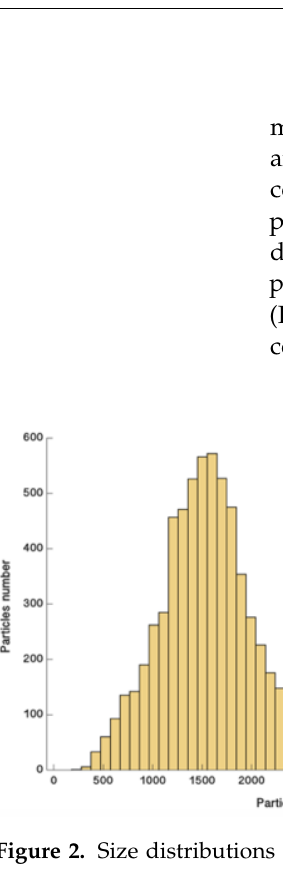
Figure 1. Morphologies of Titan’s tholins obtained with a FEG SEM for the images ( a ) – ( d ), and an environment SEM for the images ( e ), ( f ), at different magnifications. ( a ) and ( b ) show spherical monomers formed from the coagulation of primary monomers (evolution of aggregate). ( c ) and ( d ) present aggregated monomers. ( e ) and ( f ) show agglomerates of spherical grains and aggregates.